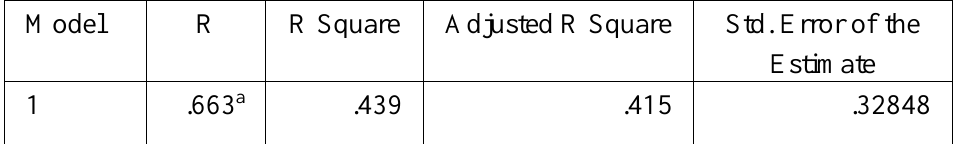
Table 3- Model summary of Multiple Regression